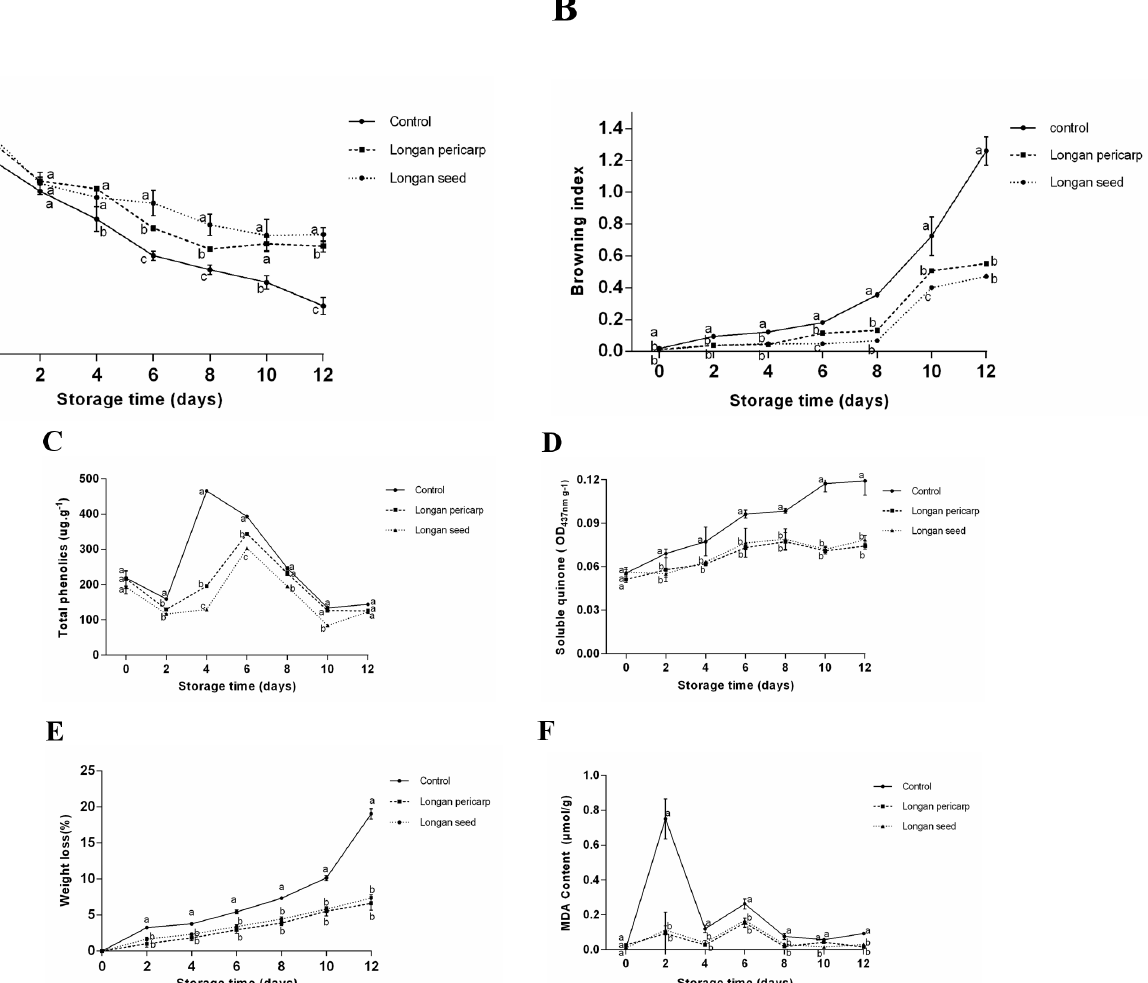
Figure 5. The preservation effect of fresh-cut lotus roots after being treated with different solutions during storage for 12 days at 4 °C: ( A ) changes in color values; ( B ) changes in the browning index; ( C ) changes in the total phenolic contents; ( D ) changes in the soluble quinone contents; ( E ) changes in weight loss (%); ( F ) changes in the MDA content. Letters indicate statistical significance. In the results, “a” represents the reference group, b represents significant differences with the “a” group (such as p < 0.05), c represents more significant differences with the “a” group (such as p < 0.01 )